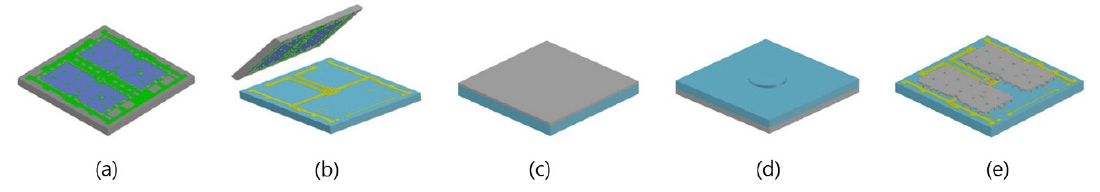
Figure 6. Chip Fabrication Process for Type II: ( a ) anchor formation; ( b ) electrode patterning and anodic bonding; ( c ) silicon thinning by grinding and CMP; ( d ) pillar formation by powder blasting; and ( e ) detailed structure formation